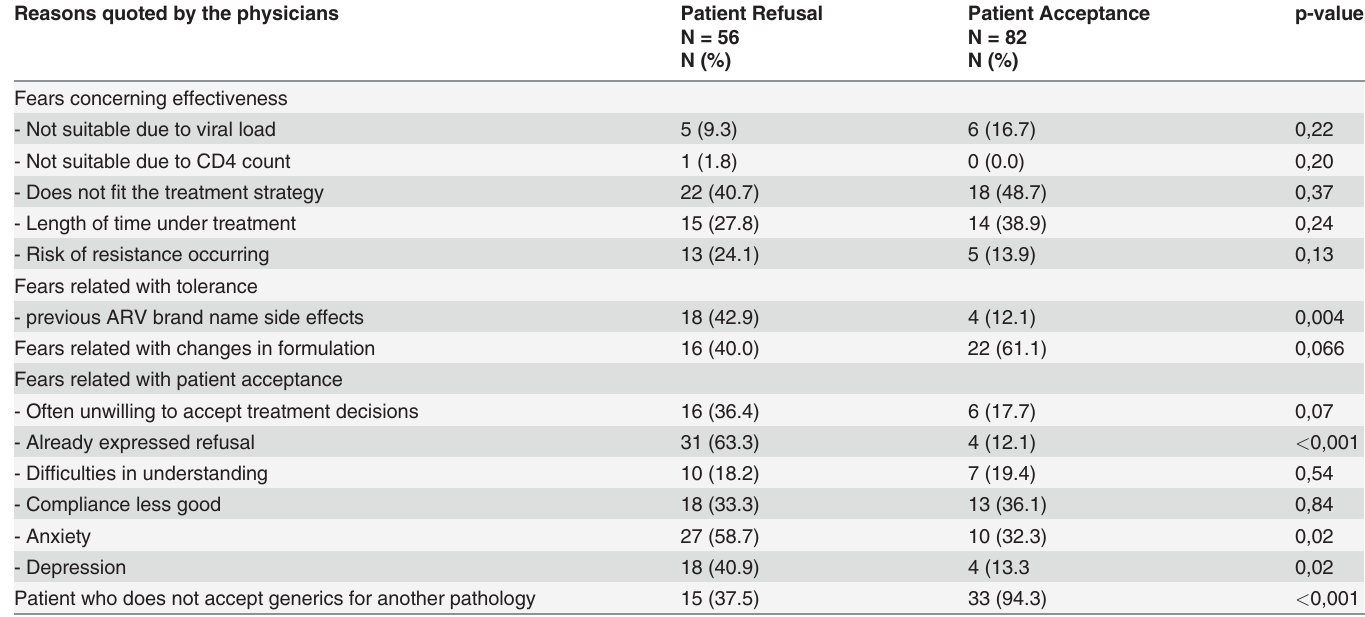
Table 5. Reasons for physician's refusal (N = 138) associated with patient's refusal to use ARV generics. Reasons quoted by the